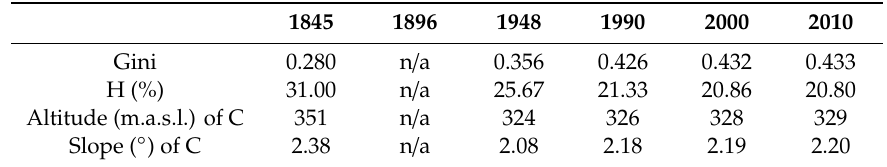
Table6. Changingdistributionofbuilt-upareas: Gini, H,averagealtitude, andslopefortheconcentrated half of BTUs Table 6. Changing distribution of built-up areas: Gini, H, average altitude, and slope for the concentrated half of BTUs (C).